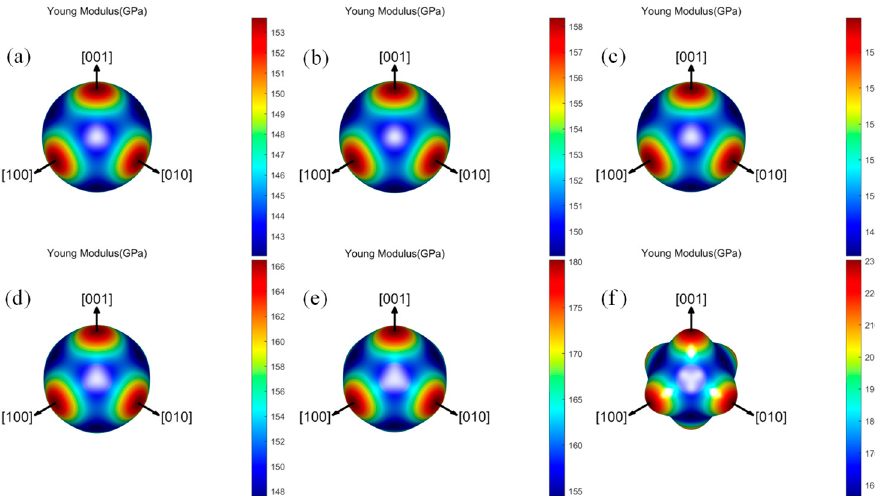
Figure 8. The Young’s modulus 3D surface of Ta–W alloys with di ff erent W contents: ( a ) Ta–6.25W, ( b ) Ta–12.5W, ( c ) Ta–18.75W, ( d ) Ta–25.00W, ( e ) Ta–31.25W, ( f ) Ta–50.00W.